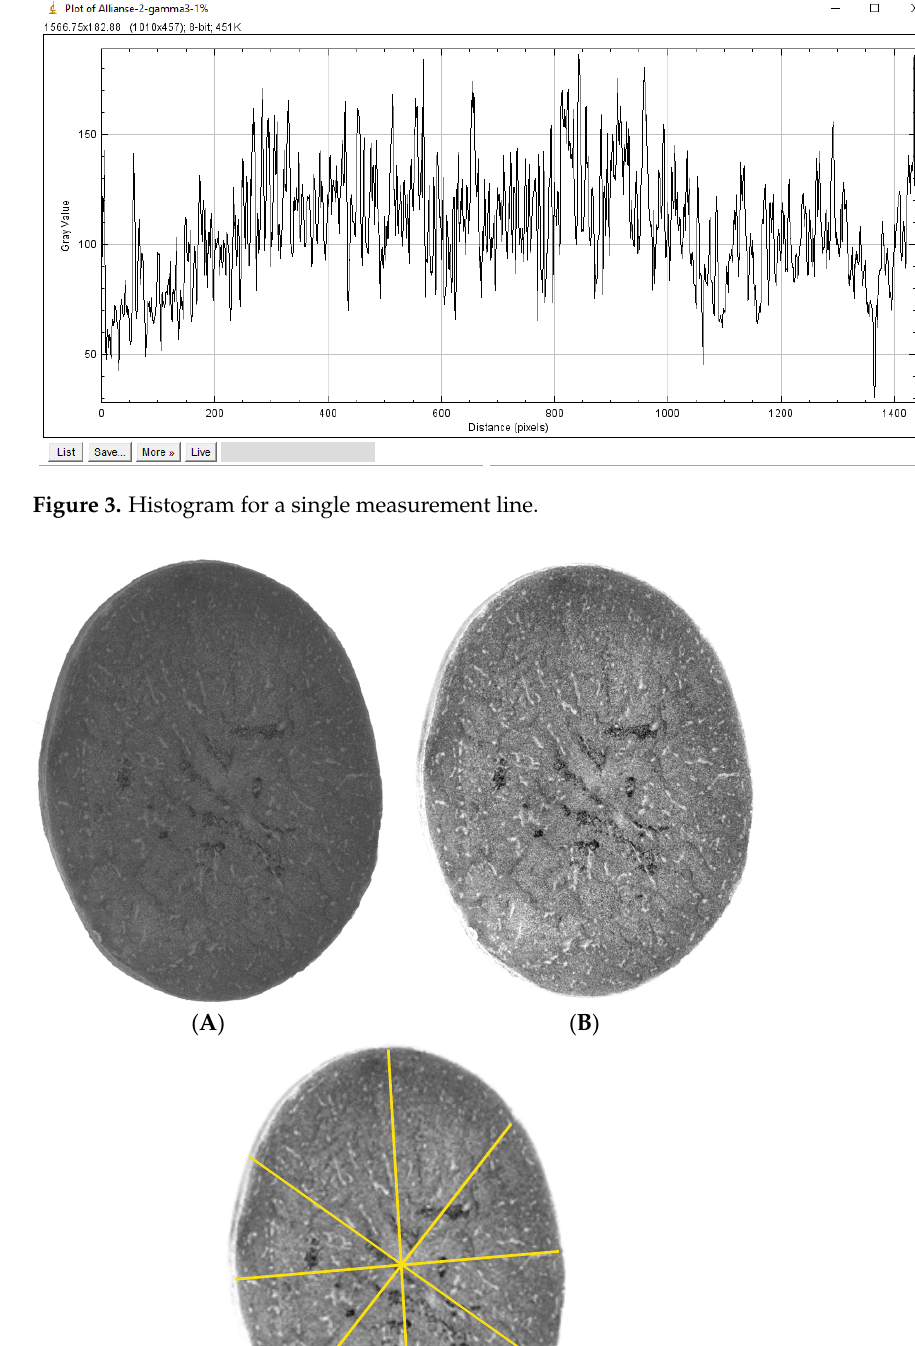
Figure 2. Change in the range of image brightness: ( A ) histogram before the change; ( B ) histogram after the change.